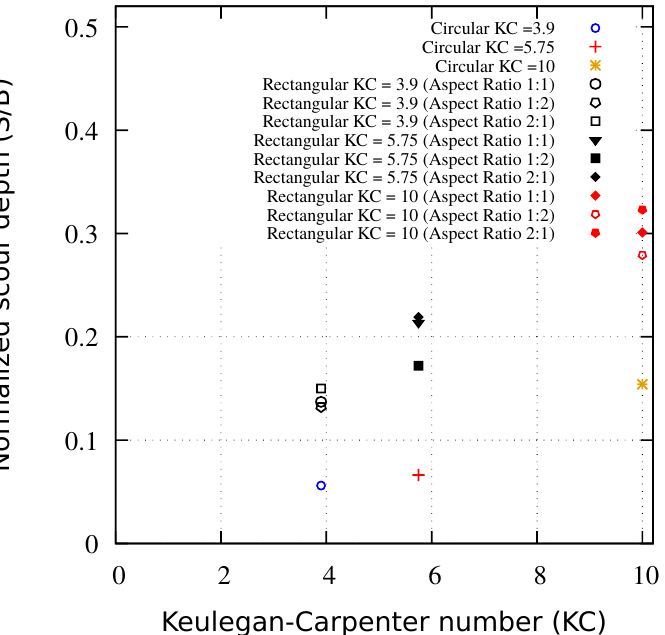
Figure 18. Normalized scour depth plotted against the KC number for different aspect ratios of the rectangular